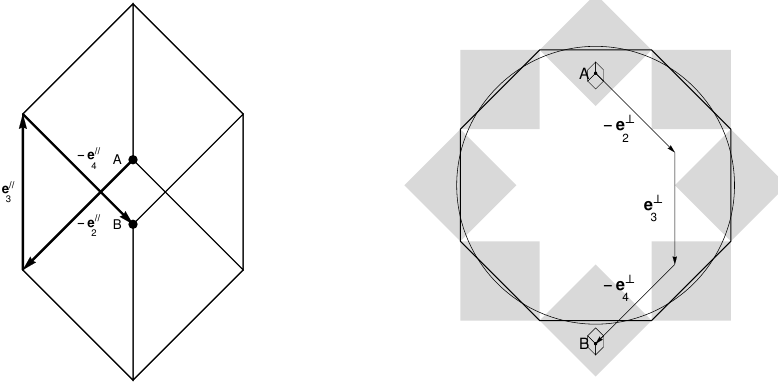
Figure 8. A pair of twin-sites in real ( left ) and in perpendicular space ( right ). In each case, the three lattice displacement vectors connecting the members of the pair are shown. Grey areas represent the total zones of existence of the two